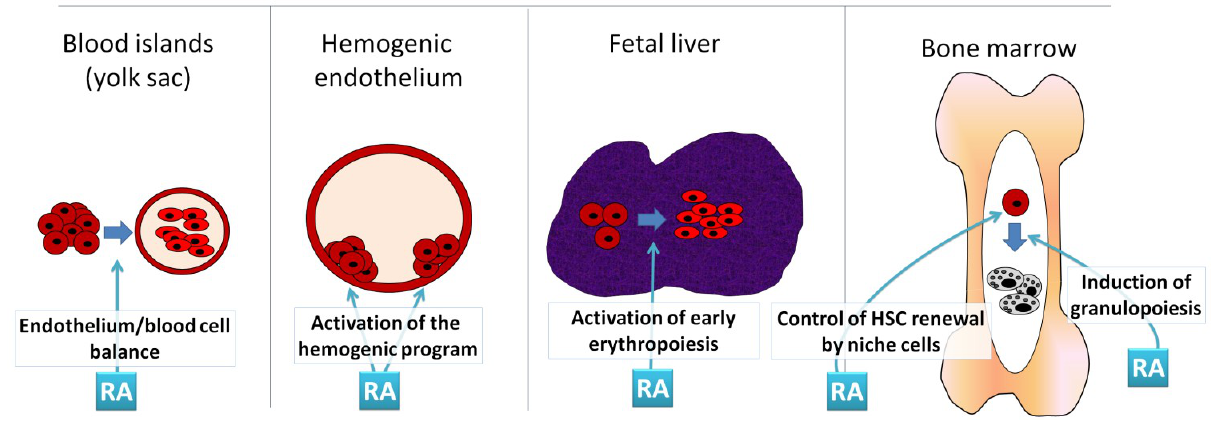
Figure 1. Main steps of the embryonic and adult hematopoiesis in which the retinoic acid signaling system is